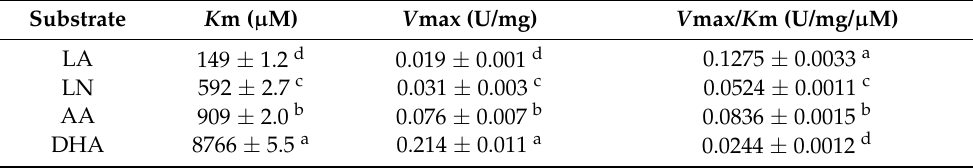
Table 2. Values of kinetic parameters for recombinant porcine 12-LOXcd (mean ± SD, n = 3) 1 .